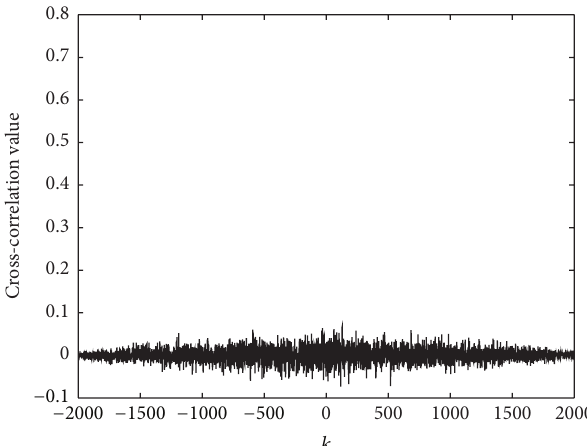
Figure 6: Cross-correlation of chaos sequences for 𝑥 0 = 0.329998 and 𝑥 0 = 0.329999 , 𝜇 = 4 , and 𝑁 = 2000